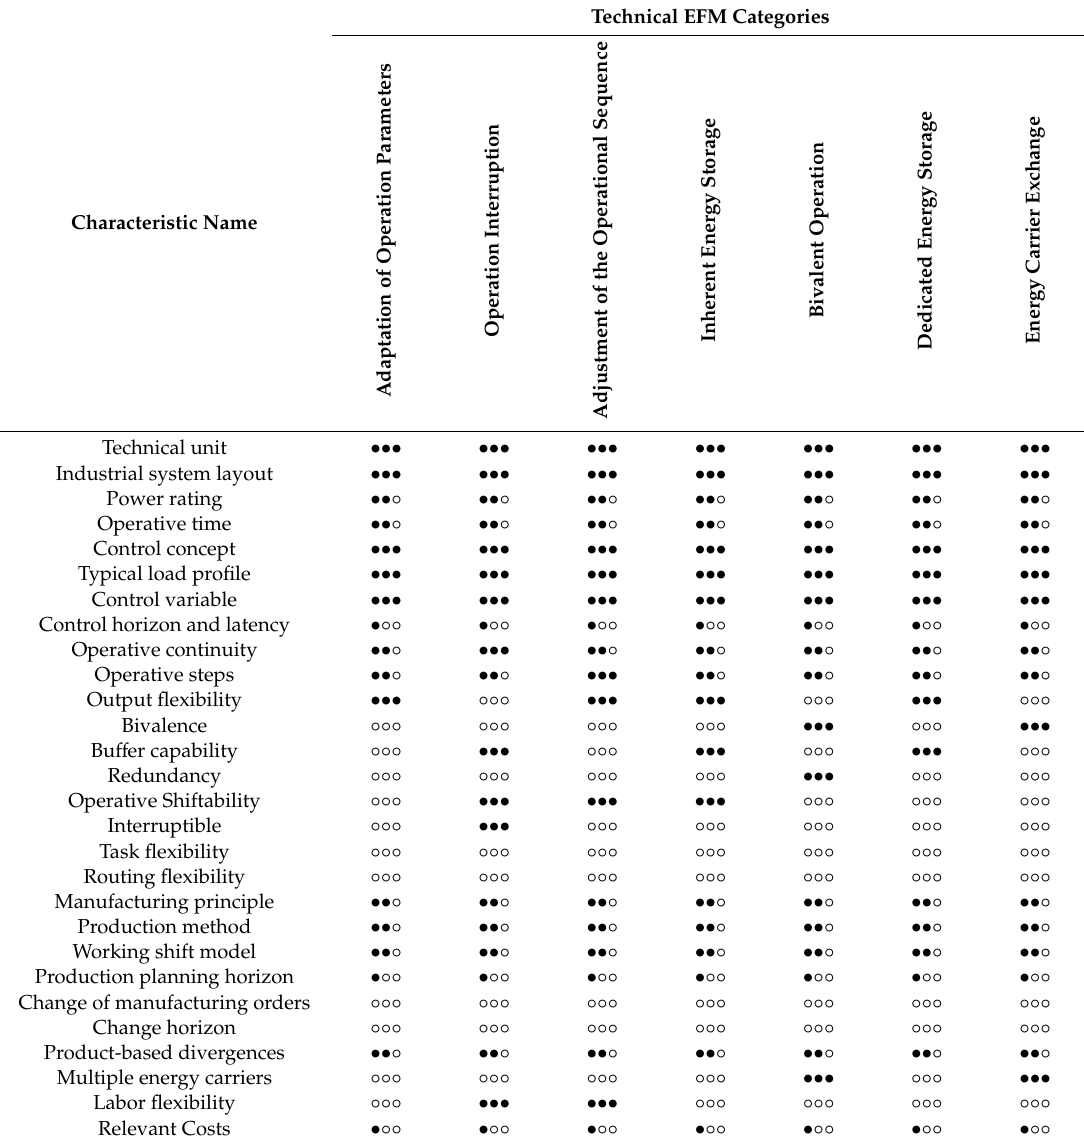
Table 3. Level of influence of the physical, operative and production characteristics in the existence of technical EFMs 1